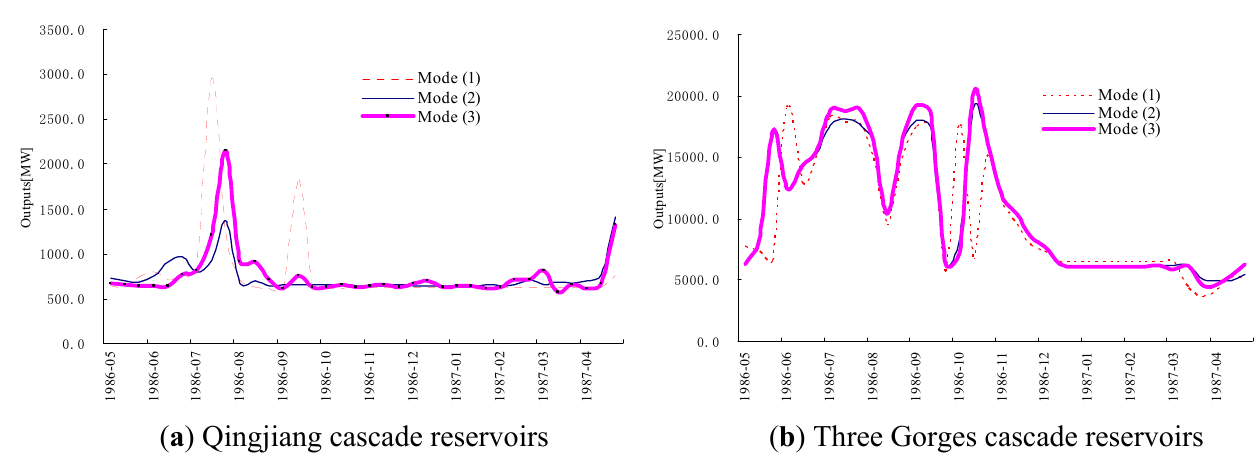
Figure 7. Comparison of the outputs for three operation modes (dry